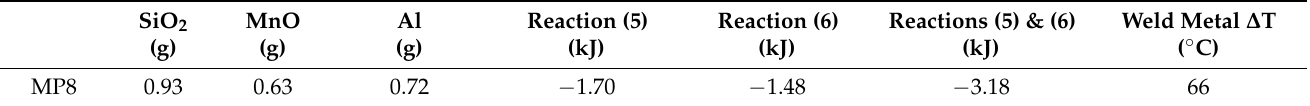
Table 6. Exothermic heat added to the weld pool from reactions (5) and